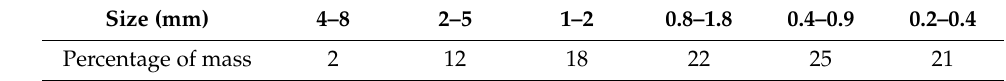
Table 4. Grading combination for